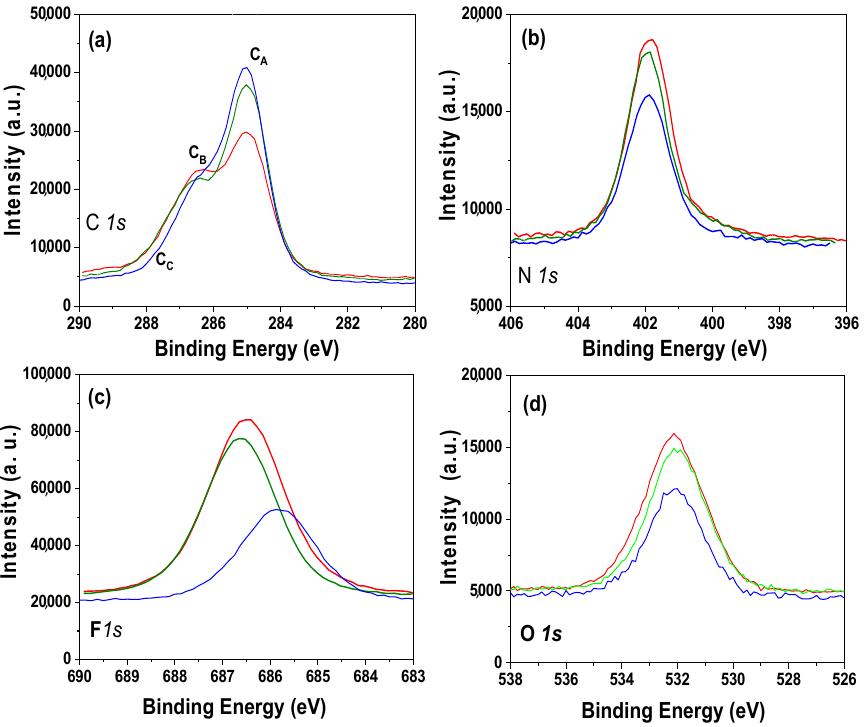
Figure 2. Core level signals for BMIMPF 6 /NPAS (red line), OMIMPF 6 /NPAS (green line), and EMIMBF 4 /NPAS (blue line) samples. ( a ) C 1s ; ( b ) N 1s ; ( c ) F 1s ; ( d ) O 1s . Dashed black line corresponds to NPAS support.